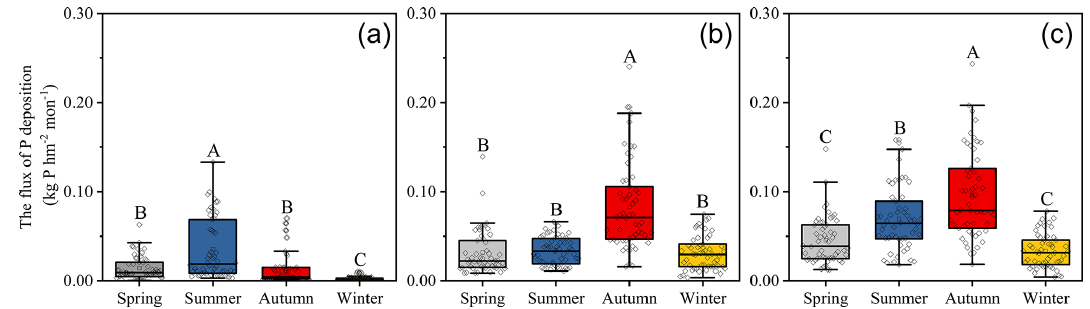
Figure 4. Monthly phosphorus flux of wet (a) , dry (b) and total (c) deposition in four seasons. Different capital letters indicate that the differences among seasons are significant (one-way ANOVA, p